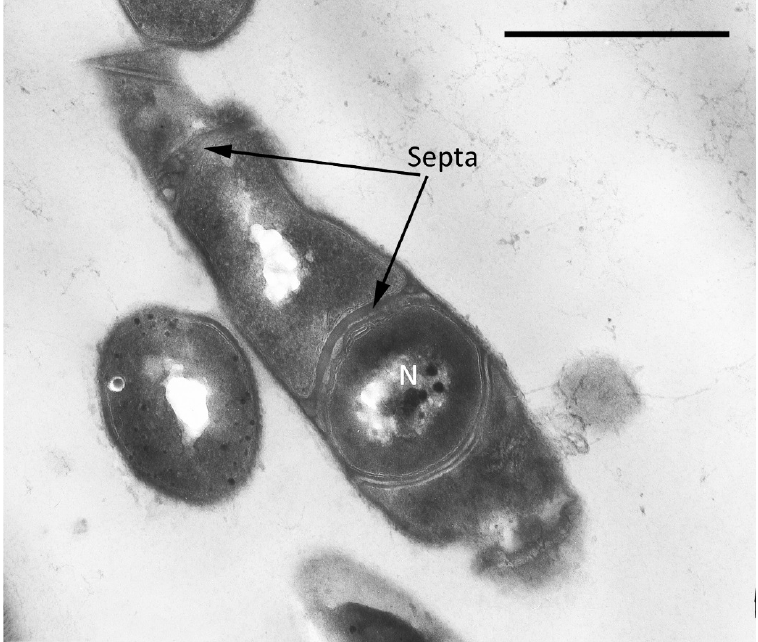
Figure 9. Ultrathin section of CLCs of G. polyisoprenivorans 135 with a septum formed inside the cytoplasm (2 years of storage). Designation: N—nucleoid. Bar—1 μ m.